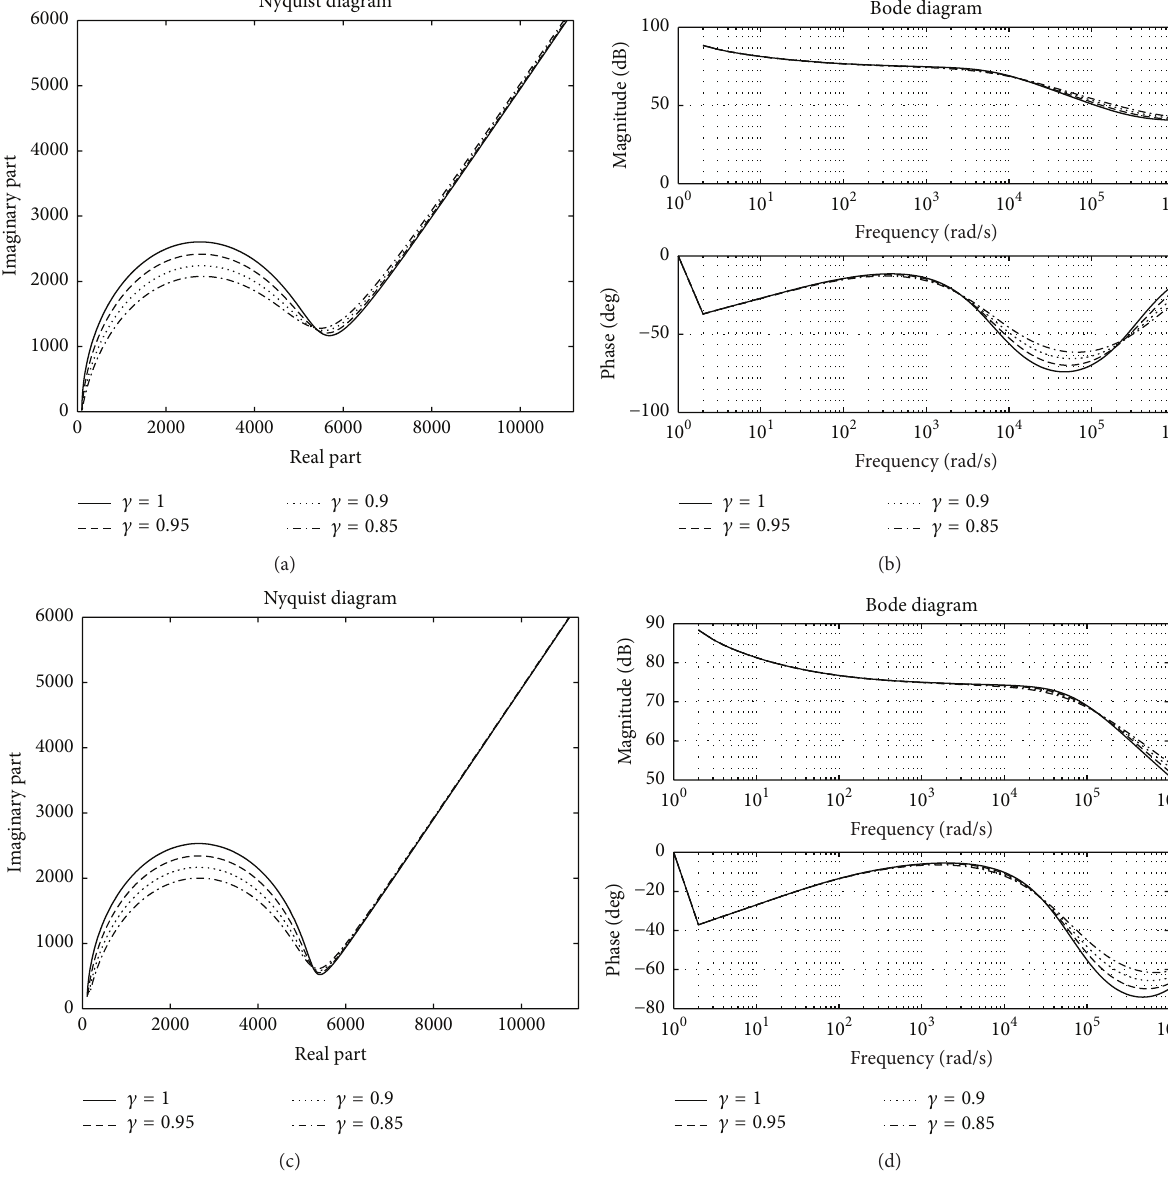
𝛾 = 1 , 𝛾 = 0.95 , 𝛾 = 0.9 , and 𝛾 = 0.85 ; for (c) and (d), 𝑅 𝑠 ,